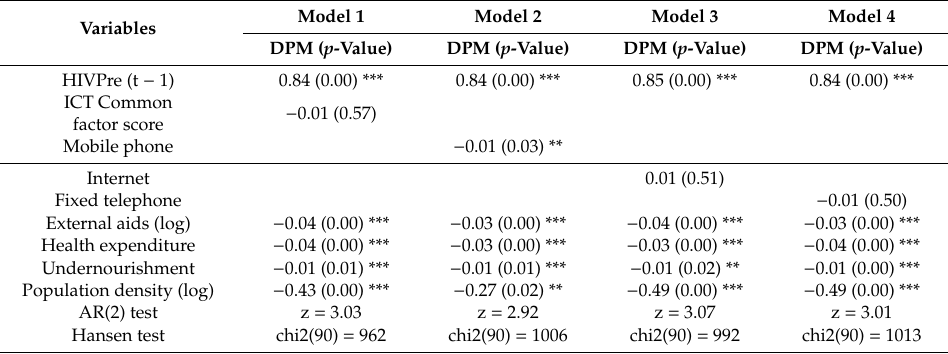
Table 2. Estimation results: information and communication technology (ICT) and HIV prevalence.